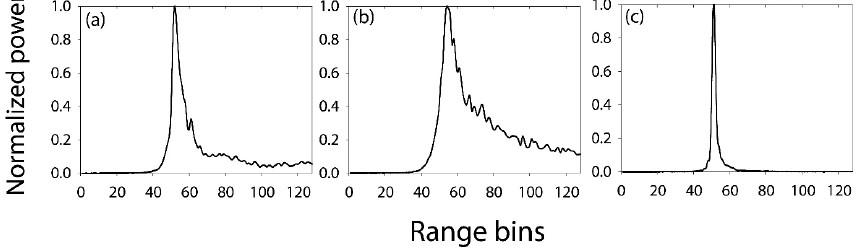
Figure 5. Typical normalized echo power waveform of CryoSat-2 SAR mode data over: ( a ) sea ice; ( b ) ocean; and ( c ) leads.